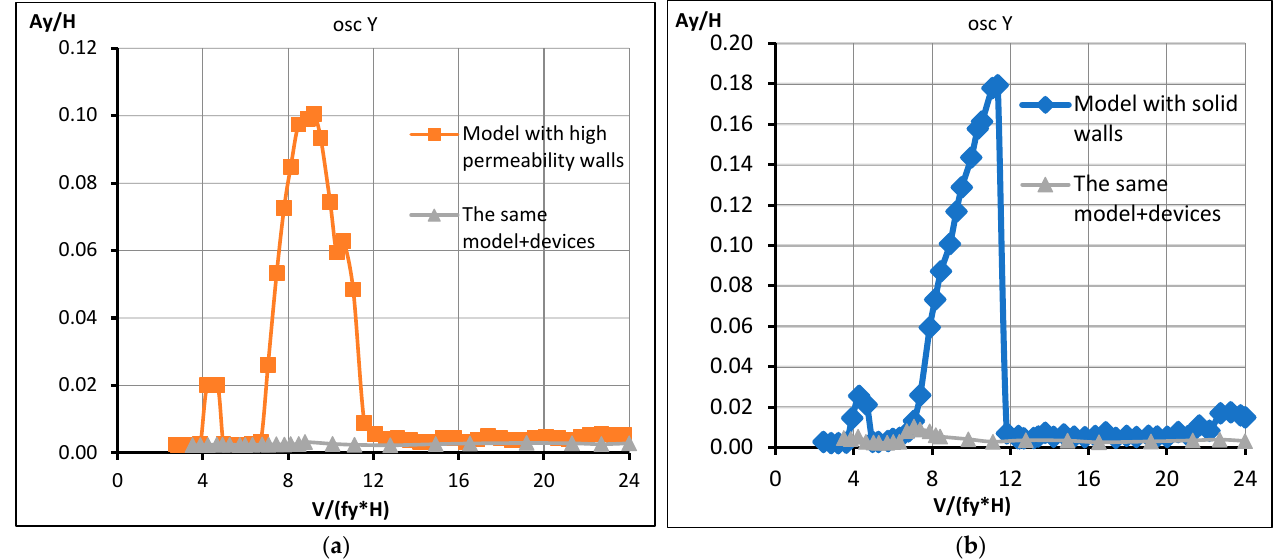
Figure 13. Comparative efficiency of vibration damping devices: Model with wall permeability ( a ), without ( b ).